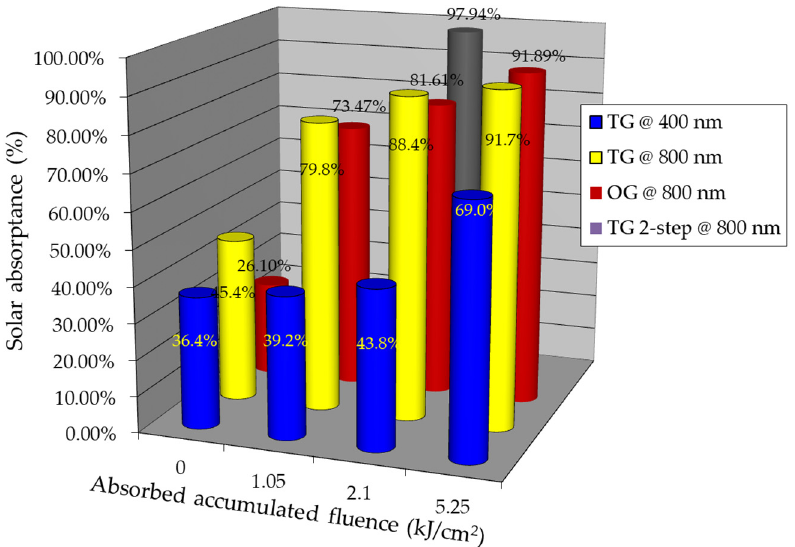
Figure 8. Solar absorptance values measured for different sets of black diamond films: Thermal grade (TG) samples treated at laser wavelengths of 400 and 800 nm with a single pass; optical grade (OG) samples treated at laser wavelength of 800 nm with a single pass; TG treated at laser wavelengths of 800 nm with a double pass. The values were derived from absorptance spectra measured by means of the Perkin Elmer Lambda 950 spectral photometer under total transmission and reflection measurements in a 150 mm integrating optical sphere in the wavelength range 200–2000 nm.